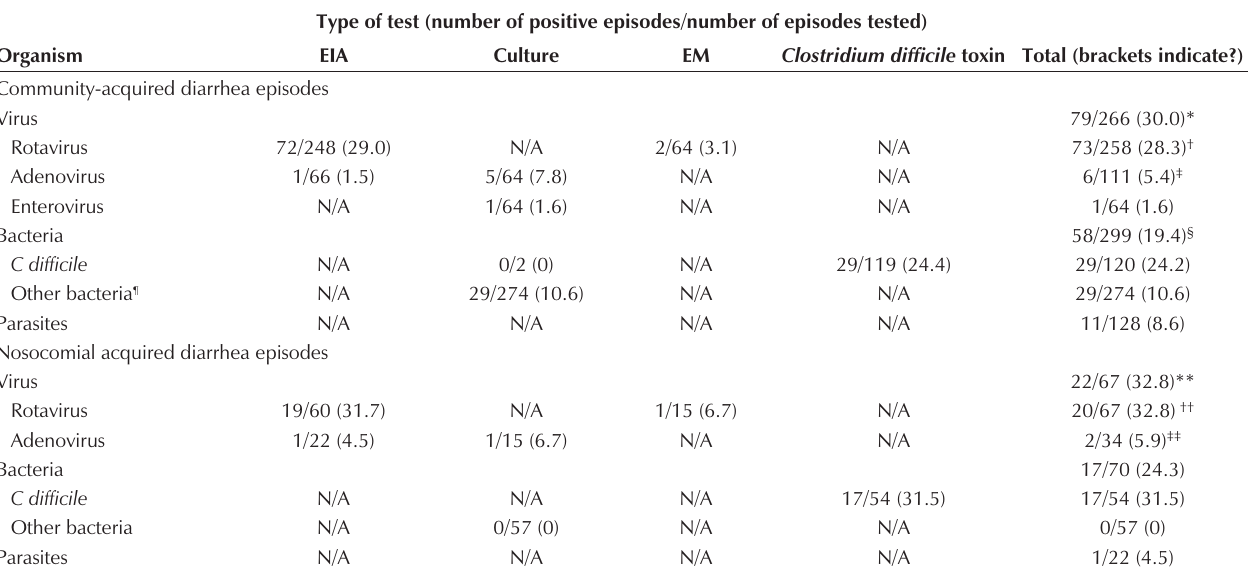
Organisms identified in diarrheal episodes at the Alberta Children’s Hospital, Calgary, Alberta from April 1, 1993 to March 30, 1995 Type of test (number of positive episodes/number of episodes tested) Organism EIA Culture Clostridium difficile toxin Total (brackets indicate?)